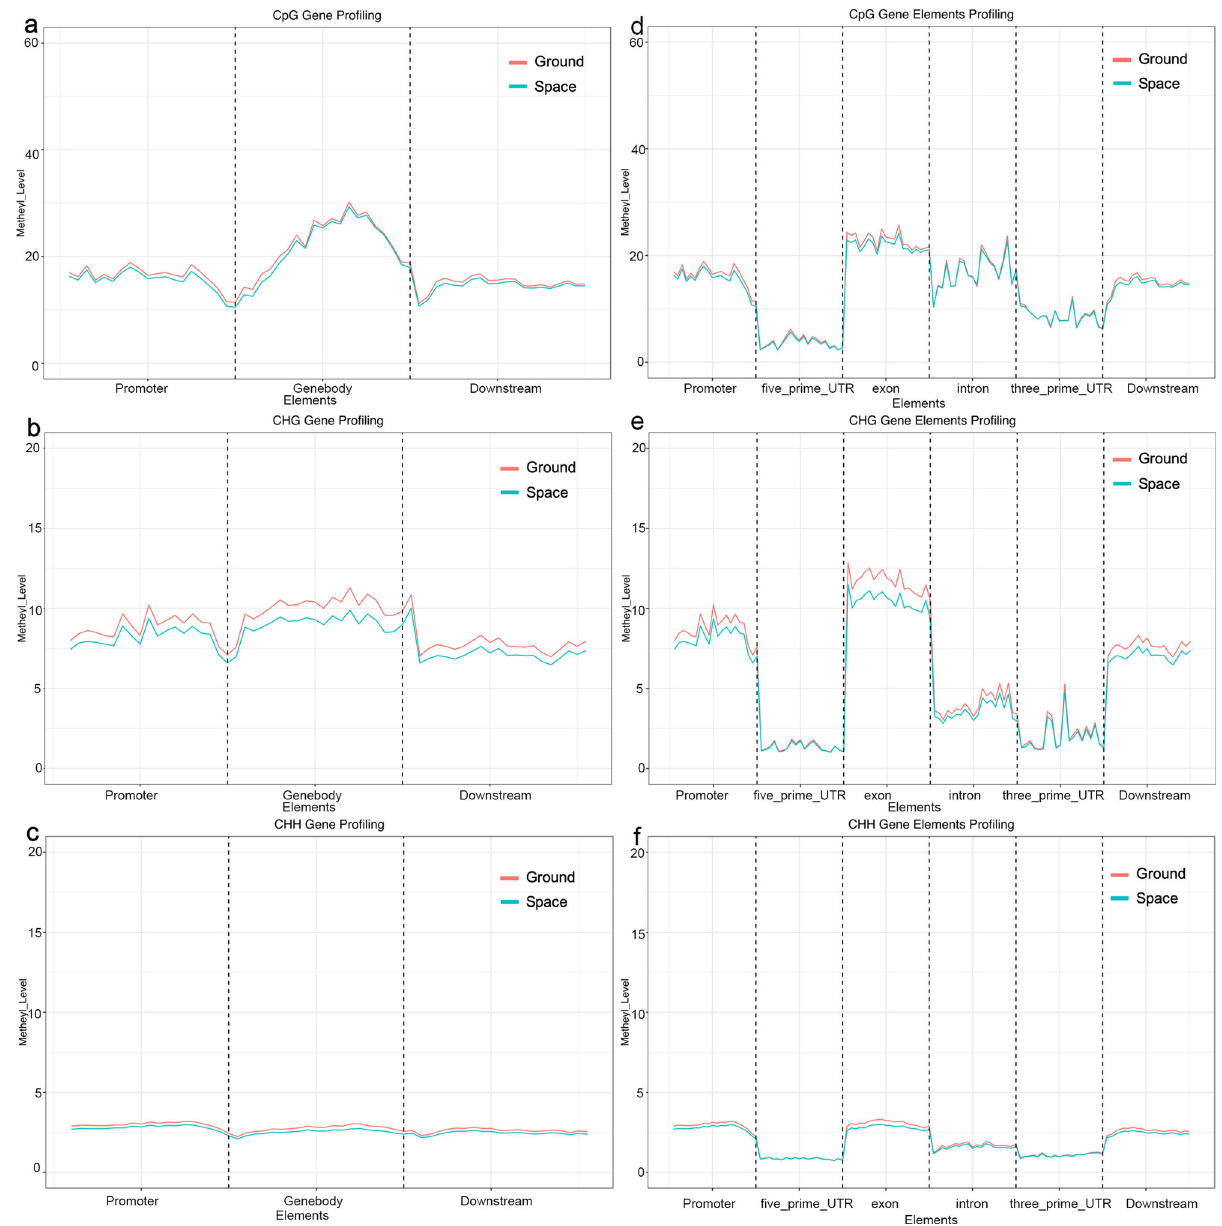
Fig. 5 DNA methylation patterns in the Arabidopsis genome of the F1 generations of the space fl ight and ground control samples. A line chart showing methylation of the Arabidopsis genome in the F 1 generation of the ground control and space fl ight samples. In a , d CpG, b , e CHG, and c , f CHH environments, including promoters, 5 ’ untranslated region (UTR), gene bodies, and 3 ’ UTR and distribution of DNA methylation levels in offspring of plants maintained under control and space fl ight conditions. The x -axis represents the gene body and its 2-kb upstream and downstream regions. a – c The y -axis represents the average methylation level. d – f The fi gure shows three types of methylation patterns, namely CHG, CHH, and